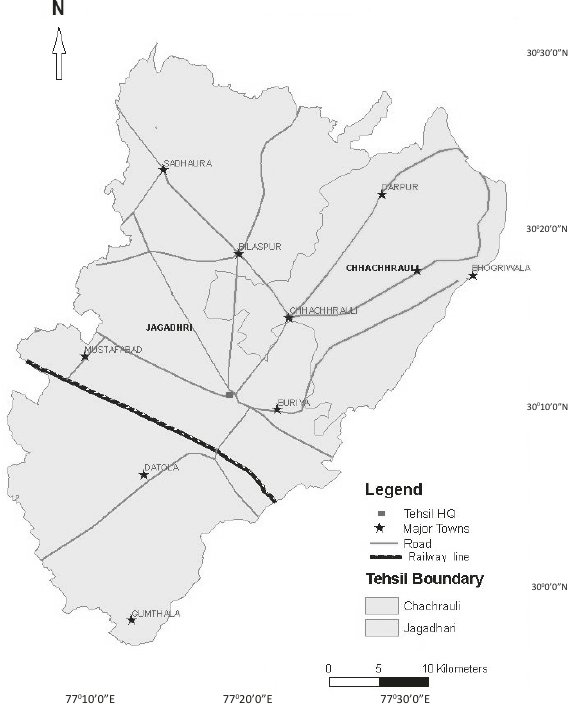
Figure 2. Yamuna Nagar District